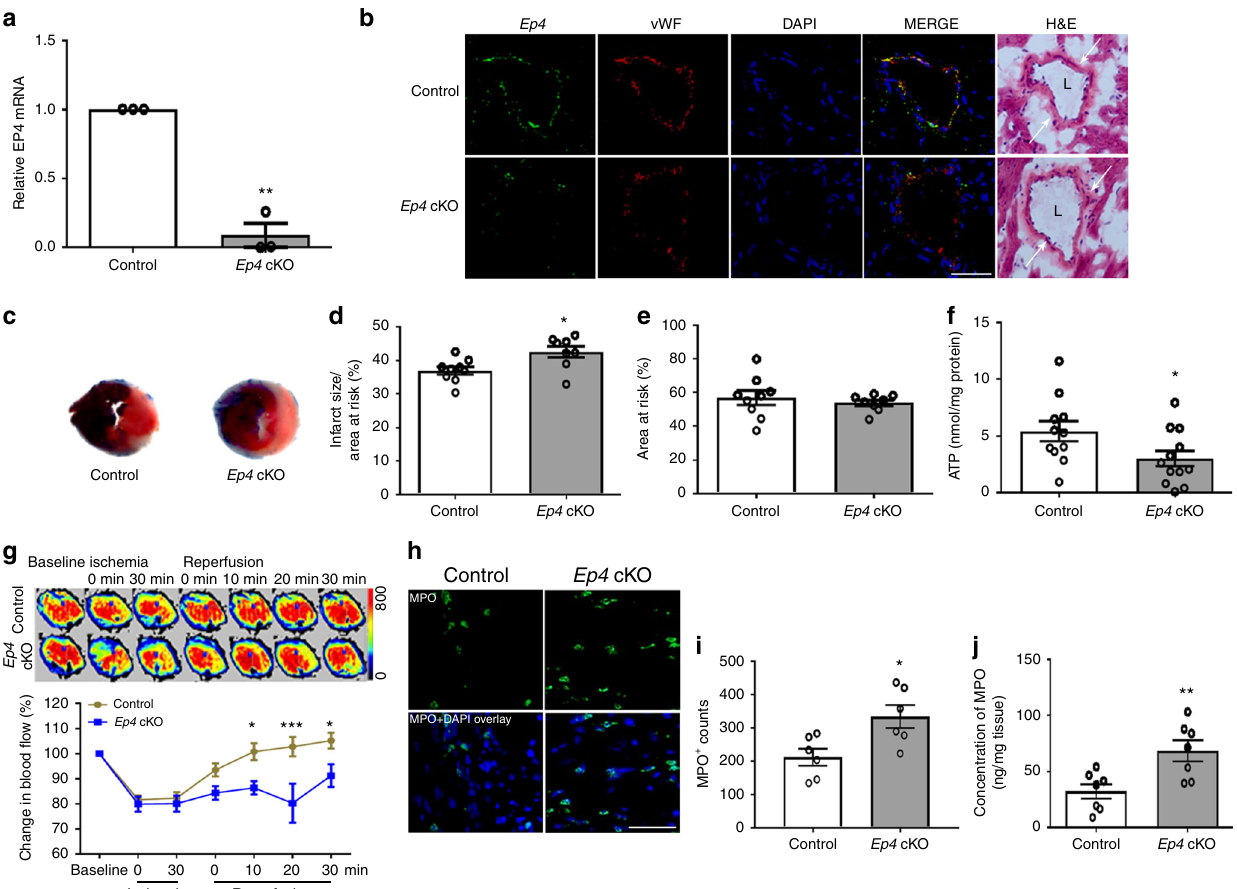
Fig. 6 EC Ep4 deletion impairs microcirculation and increases infarct size in MI/R. Expression of Ep4 was examined by RT-PCR in the mouse lung ECs isolated from tamoxifen treated Ep4 conditional KO mice (cKO) and littermate controls ( a ). Hearts were isolated 24 h after MI/R, and tissue sections were stained for EP4 (green), vWF (an EC marker, red) and nuclei (DAPI, blue). Representative result from three studies was shown ( b ). Representative TTC stained sections of the Evans blue perfused hearts were shown ( c ). Infarct size ( d ) and AAR ( e ) were quanti fi ed. Levels of ATP in the injured myocardium 24 h post IR were measured ( f ). Cardiac blood perfusion during I/R was measured by laser Doppler fl ow, and representative images were shown above the fl ow plot ( g ). Tissue expression of MPO was stained ( h ) and the number of MPO-positive cells was analyzed ( i ). Heart tissue levels of MPO in the ischemic area were quanti fi ed ( j ). Unpaired Student ’ s t test ( a , n = 3; d , e , n = 9, 8; f , n = 11, 12; i , n = 6; j , n = 7). Two-way ANOVA with Turkey ’ s tests ( g , n = 15, 7). Scale bar is 50 μ m. Anatomy of vascular structure is labeled in b : arrows denote vessel wall, and ‘ L ’ denotes lumen. Error bar indicates